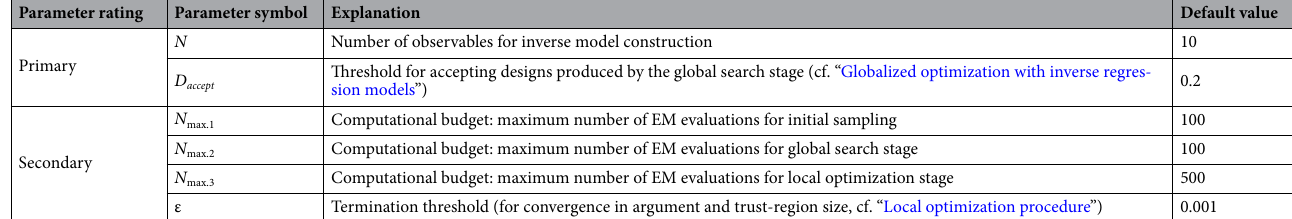
Table 1. Control parameters of the proposed framework for global microwave design optimization along with their suggested